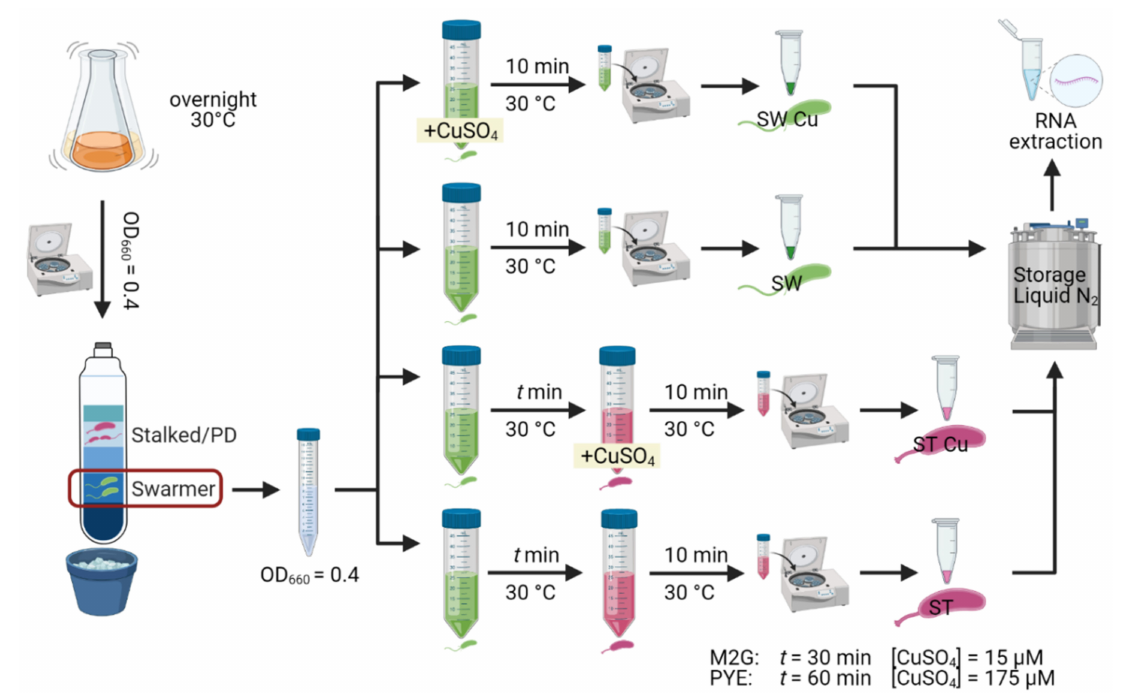
Figure 1. Overview of tagRNA-seq experimental